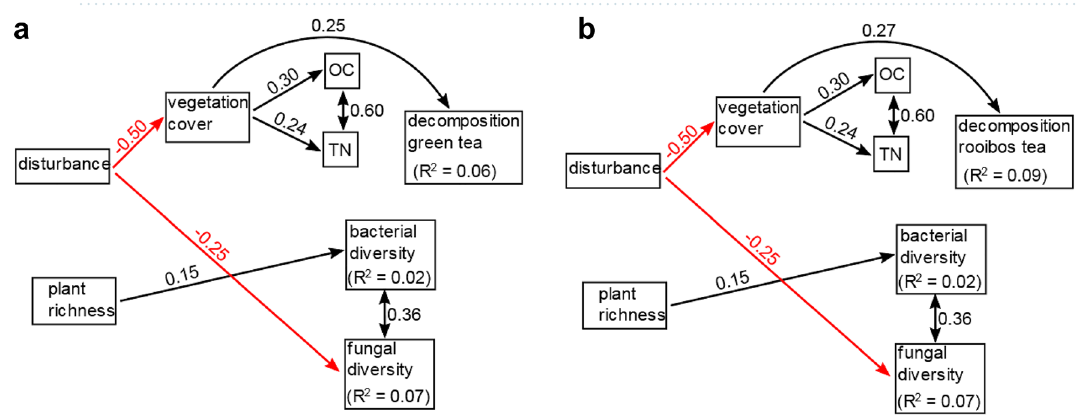
Figure 8. Structural equation models for the combination of sampling years 2016 + 2017. Subfigures show results for different soil functions as terminal response variable: decomposition of green tea ( a ), decomposition of rooibos tea ( b ). Arrows show direction of significant effects at p < 0.05, line color indicates sign of relationship (black: positive, red: negative). Double-headed arrows indicate bi-directional correlation. Standardized coefficients are given as numbers next to the arrows. Marginal R 2 -values of soil functions are given for microbial diversity and soil